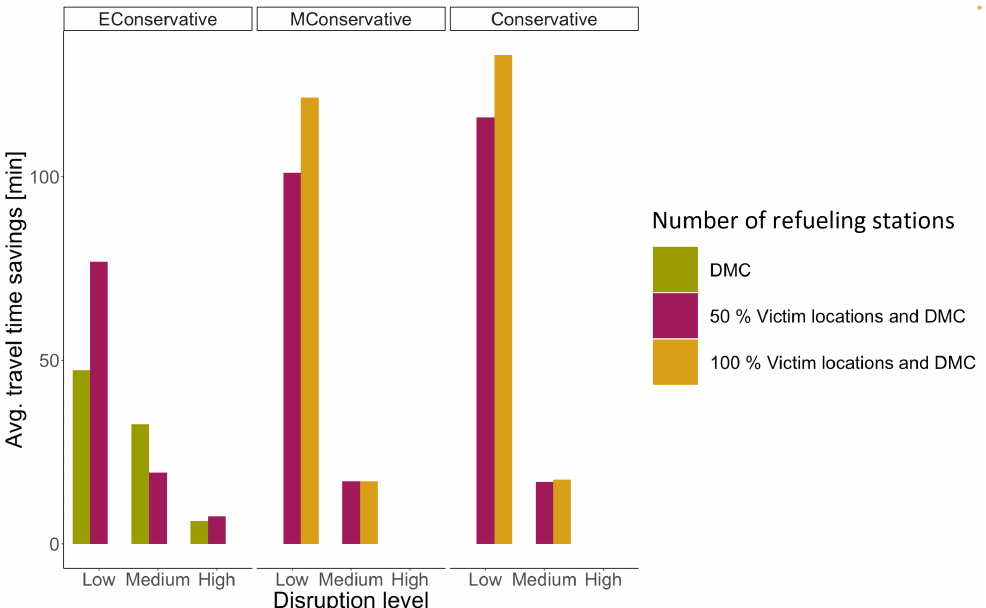
Figure 13. Cluster B: impact of the number of refueling stations on the performance of refueling strategies.